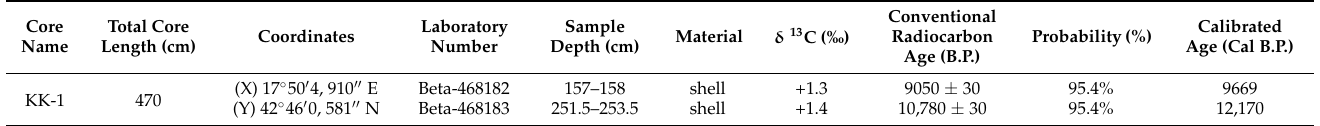
Table 1. Location of the sediment core, radiocarbon AMS dating, and sample age calibration based on the MARINE 13 curve